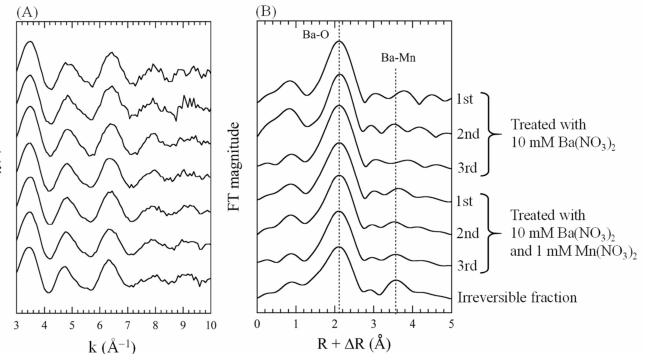
Figure 5. Ba K-edge EXAFS spectra of the newly formed BMOs treated in 10 mM Ba(NO 3 ) 2 with and without 1 mM Mn(NO 3 ) 2 , highlighting the ( A ) EXAFS oscillations and ( B ) corresponding radial structural functions (RSFs). The irreversible fraction indicates the Ba 2+ left on the BMO after extracting the reversible Ba 2+ fraction using 10 mM Cu(NO 3 )